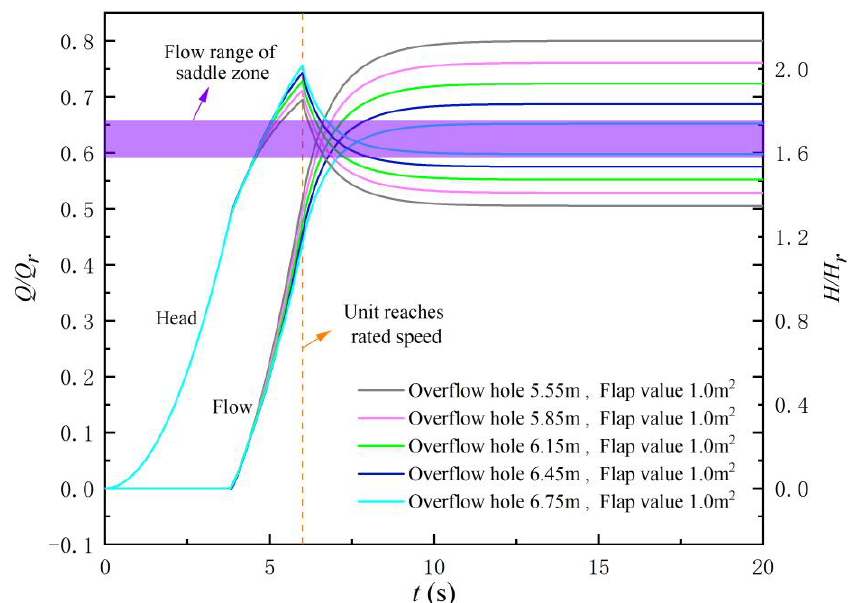
Figure 16. Variation patterns in the flow and head of LAPS equipped with OVHO and restricted FLVA under gate refusal working conditions.